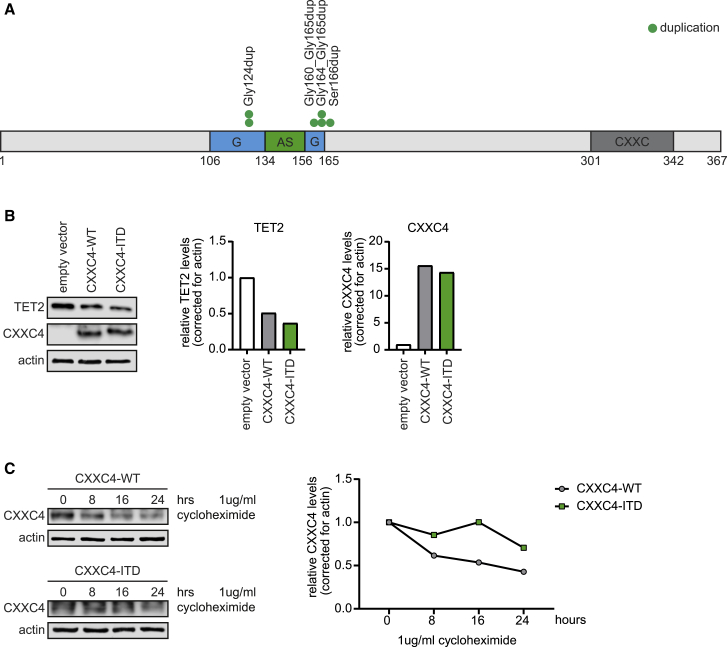
Human CXXC4-ITD Mutation Results in a More Stable CXXC4 Protein and Reduced TET2 Levels(A) Schematic overview of the human CXXC4 gene, showing CXXC4-ITD mutations in de novo AML.(B) Overexpression of wild-type (WT) or the CXXC4-ITD (duplication of glycines 160–165) in K562 cells shows a subsequent reduction in TET2 protein levels by immunoblot.(C) Representative image and quantification of an immunoblot, showing increased stability of the CXXC4-ITD protein upon prolonged treatment with 1 μg/mL cycloheximide.See also Figure S4.